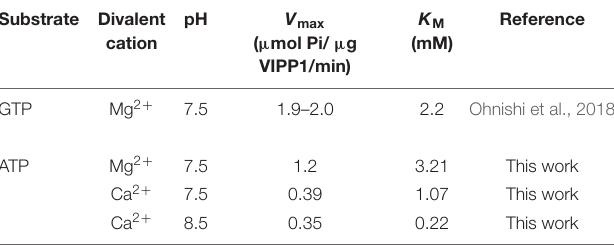
TABLE 1 | V max and K M of the ATP- and GTP-hydrolysis activities of AtVIPP1-His. Substrate Divalent